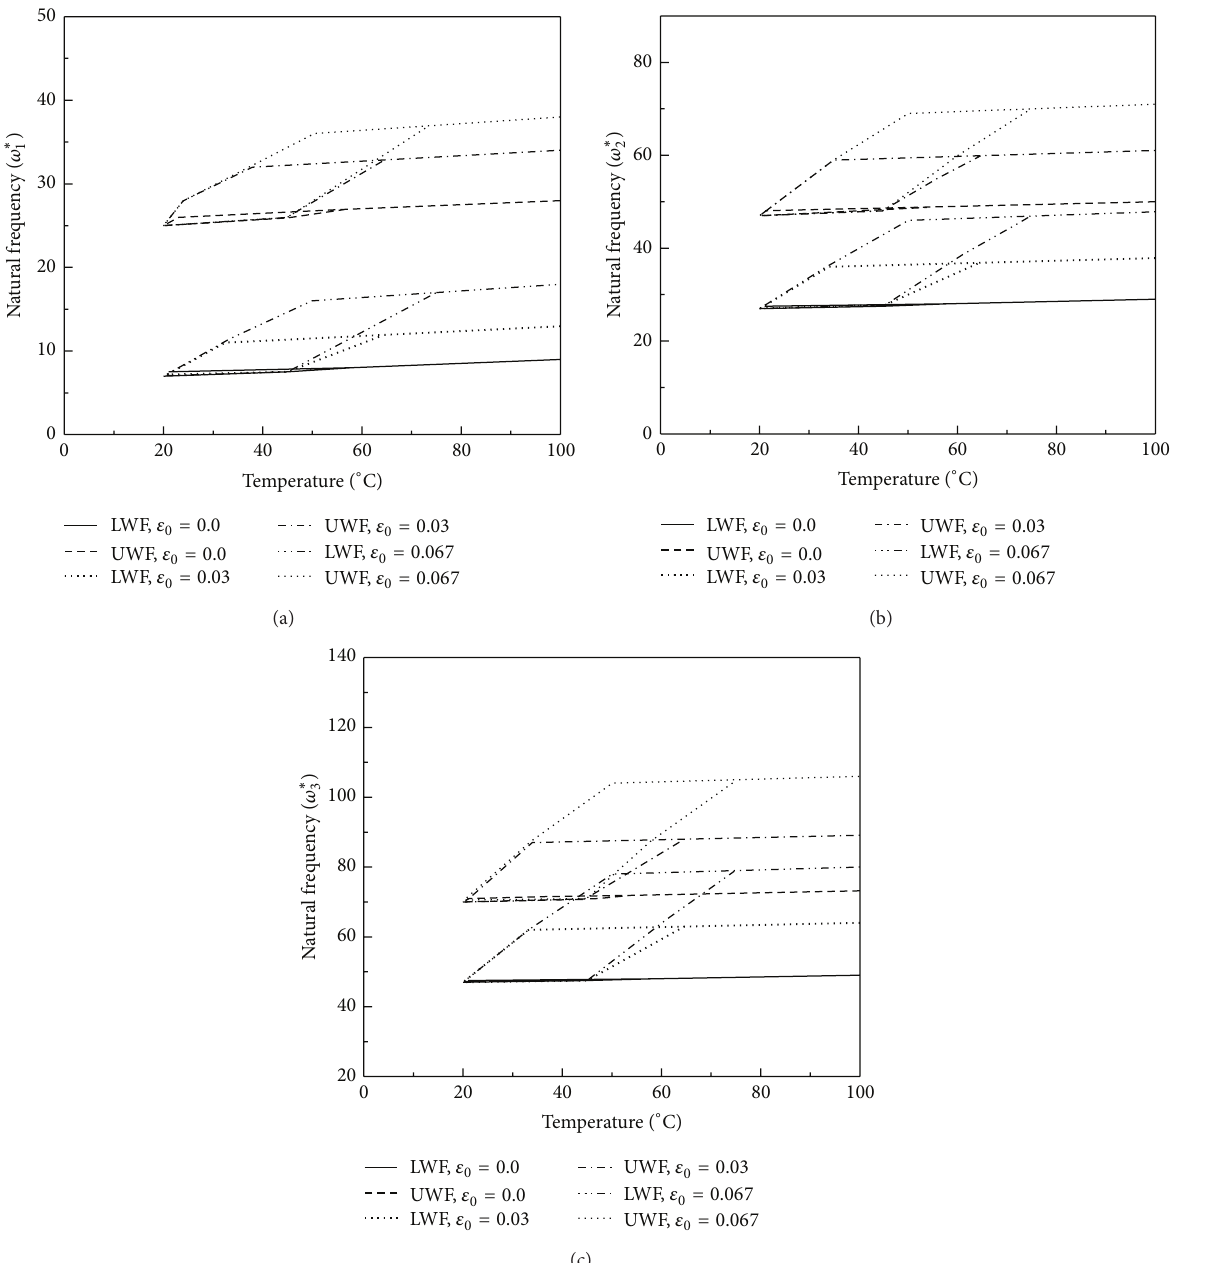
Figure 7: The first three natural frequencies versus temperature for the different initial strains of SMA wire ( 𝜃 = 30 ∘ ; 𝑇 = 50 ∘ C; 𝑉 𝑠 = 0.36 ).